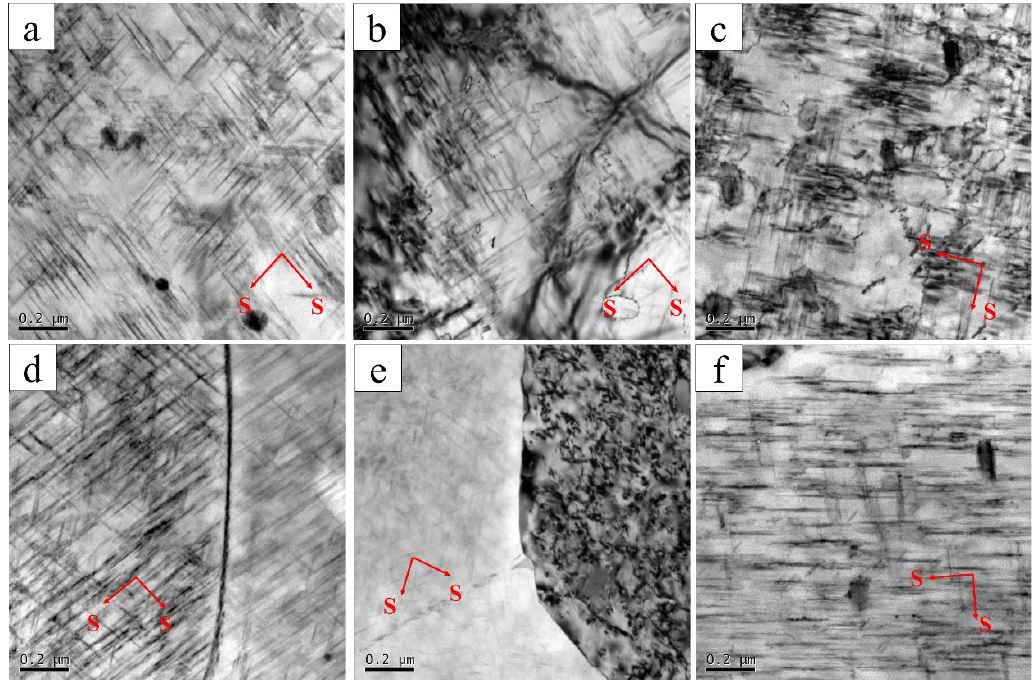
Figure 8. TEM bright field (BF) images of AA2024 alloy under different conditions, where the electron beam was close to [001] Al : ( a ) 0.3 mm, 90 MPa; ( b ) 0.3 mm, 120 MPa; ( c ) 0.3 mm,150 MPa; ( d ) 1.5 mm, 90 MPa; ( e ) 1.5 mm, 120 MPa; ( f ) 1.5 mm, 150 MPa.